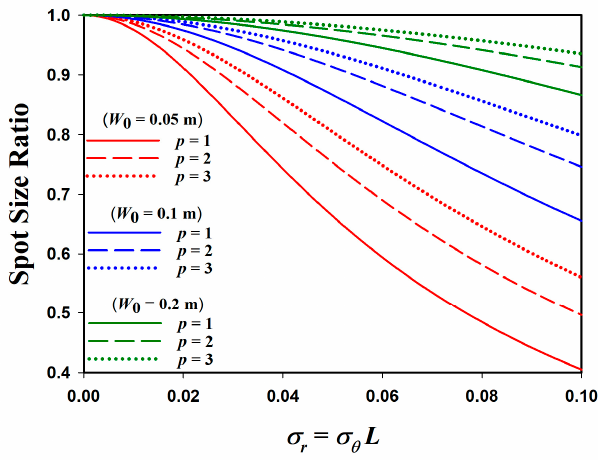
Figure 6. Changes in HG beam spot size ratio with the increase in pointing error.